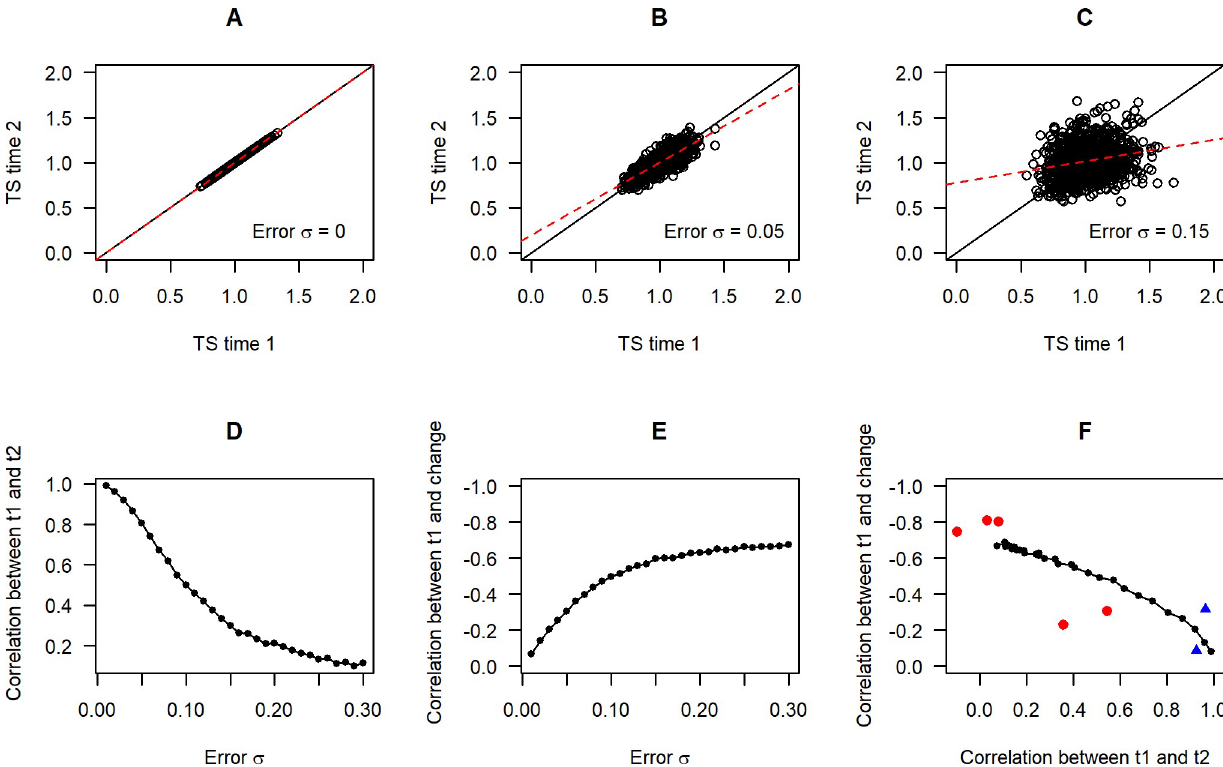
Fig 5. Consequences of measurement error for patterns in longitudinal datasets. Panels A to C: Association between mTS at time 1 and mTS at time 2 assuming no true change, for no measurement error (A), σ ε time 1 and mTS at time 2, with no true change and increasing levels of measurement error ( σ ε s = σ ε t ). Panel E: The correlation between mTS at time 1 and measured change in TS between time 1 and time 2, assuming no true change and increasing levels of measurement error ( σ ε axis scale. Panel F: Time 1-time 2 correlation against change-time 1 correlation for simulated datasets (black circles and lines). Measurement error increases from 0 at bottom right to 0.2 at top left ( σ ε s = σ ε t ). Superimposed are empirical values from the seven large human longitudinal cohorts from dataset 2. qPCR studies are shown in red and studies measuring terminal restriction fragment by Southern blot in blue. Note the reversed y-axis scale.